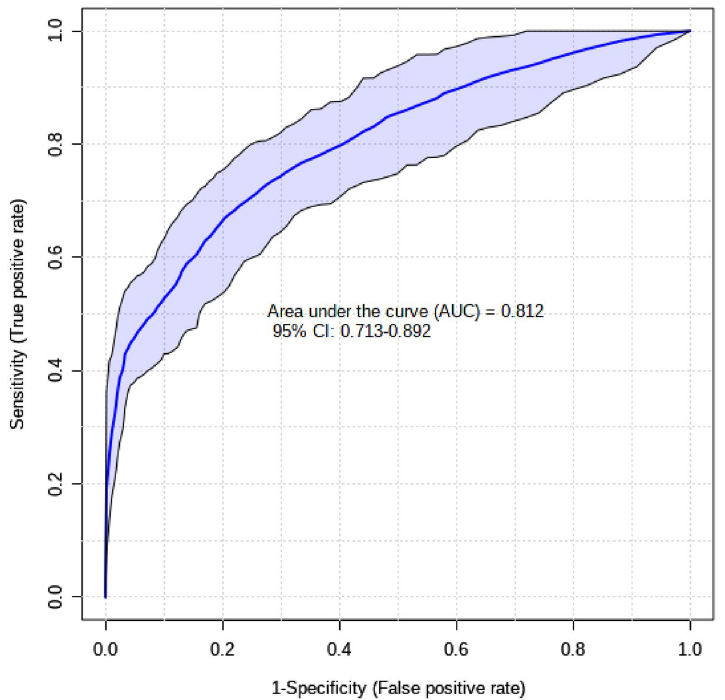
Figure 3. Receiver operating characteristics (ROC) curve of biomarkers of pregnant ewes with twin or triplet lambs. A panel of six metabolites (isobutyric acid, l-lactic acid, l-carnitine, valine, tyrosine, methanol) from comparing TWN vs TRP groups were identified as significance (p-value < 0.05) biomarkers of pregnant ewes that carry multiple